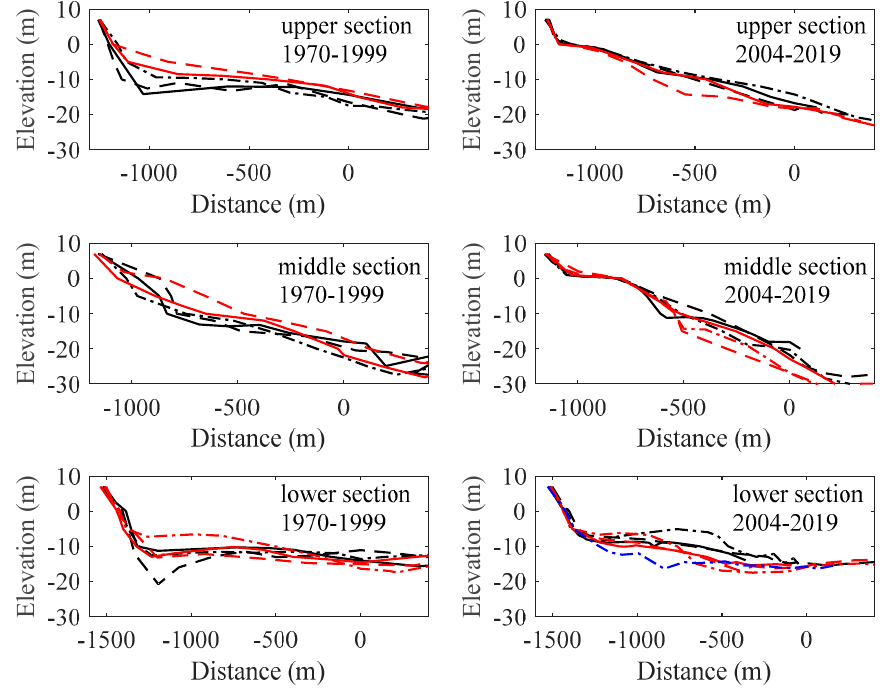
Figure 13. Long-term evolution of section elevation of Jingjiang Beach.